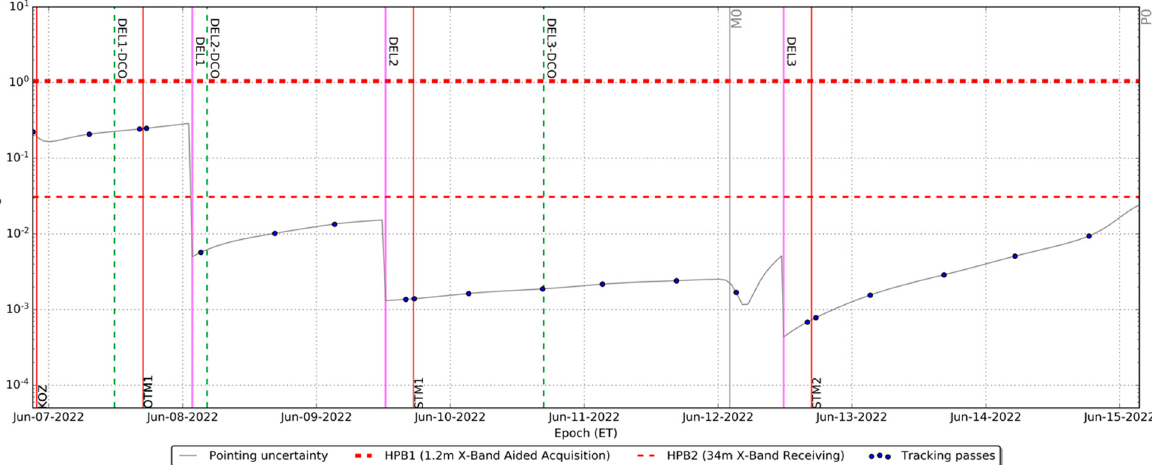
Figure 10. DSN to ArgoMoon pointing uncertainty evolution (3-sigma), during REV0. The gray line is the uncertainty evolution using the designed delivery schedule, while the blue dots identify the tracking passes.